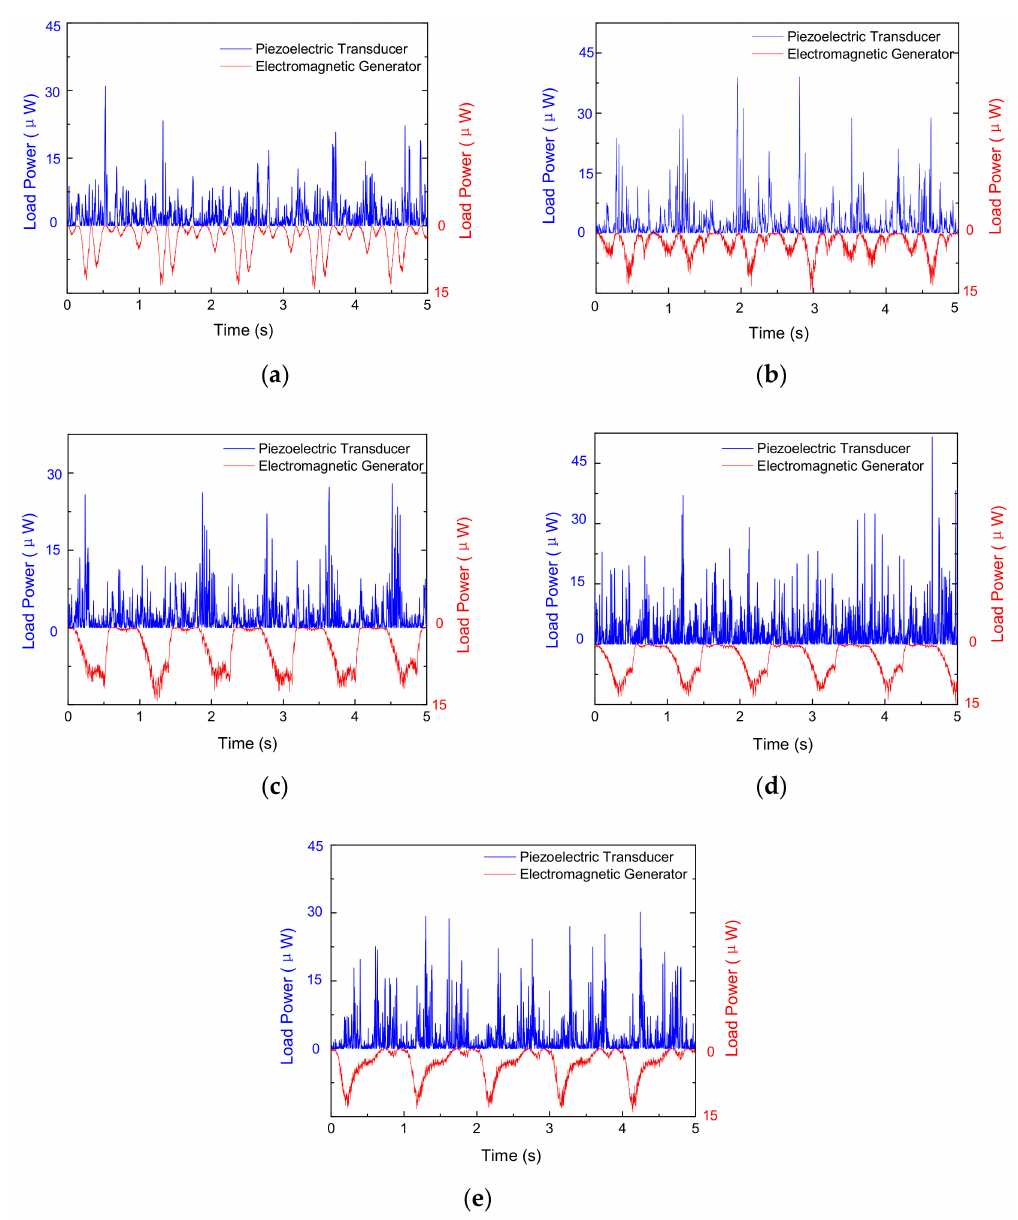
Figure 6. Output power signals (Load resistance is 270 k Ω ) of the hybrid energy harvester at different liquid levels: ( a ) h = 40 mm; ( b ) h = 60 mm; ( c ) h = 80 mm; ( d ) h = 100 mm; and ( e ) h = 120